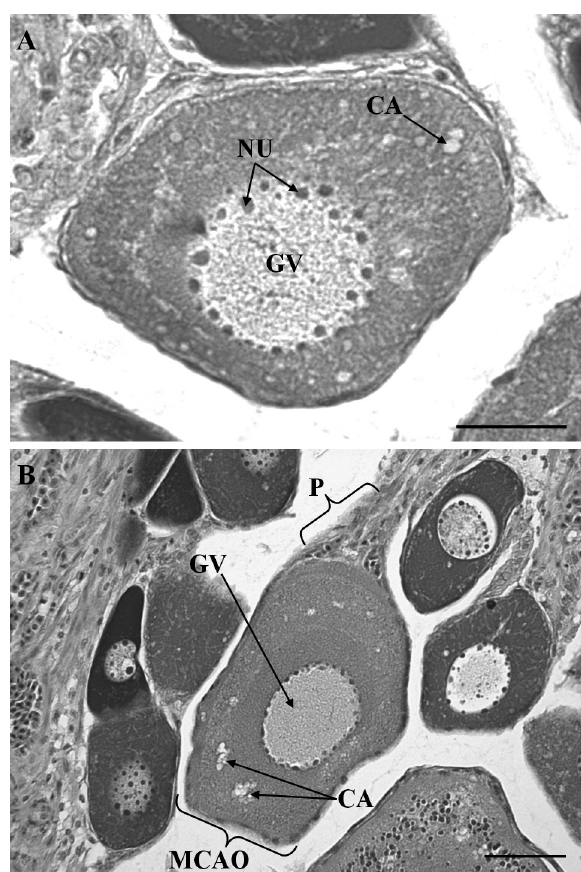
Fig . 4. – A, early cortical alveoli stage oocyte (Scale bar = 25 µm); and B, mid-cortical alveoli stage oocyte (Scale bar = 100 µm). CA, cortical alveoli; GV, germinal vesicle; MCAO, mid-cortical alveoli stage oocyte; NU, nucleoli; P,